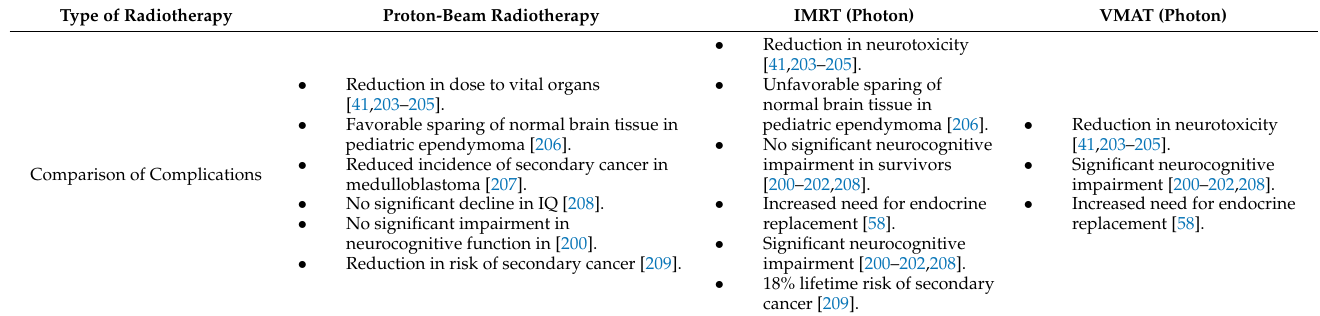
Table 3. Comparison of complications (favorable or unfavorable) in the different radiotherapy modalities. Type of Radiotherapy Proton-Beam Radiotherapy IMRT (Photon) VMAT (Photon)